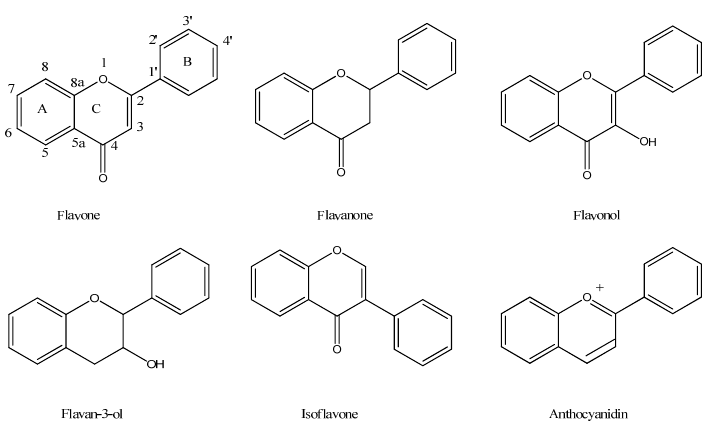
Figure 1. Structures of